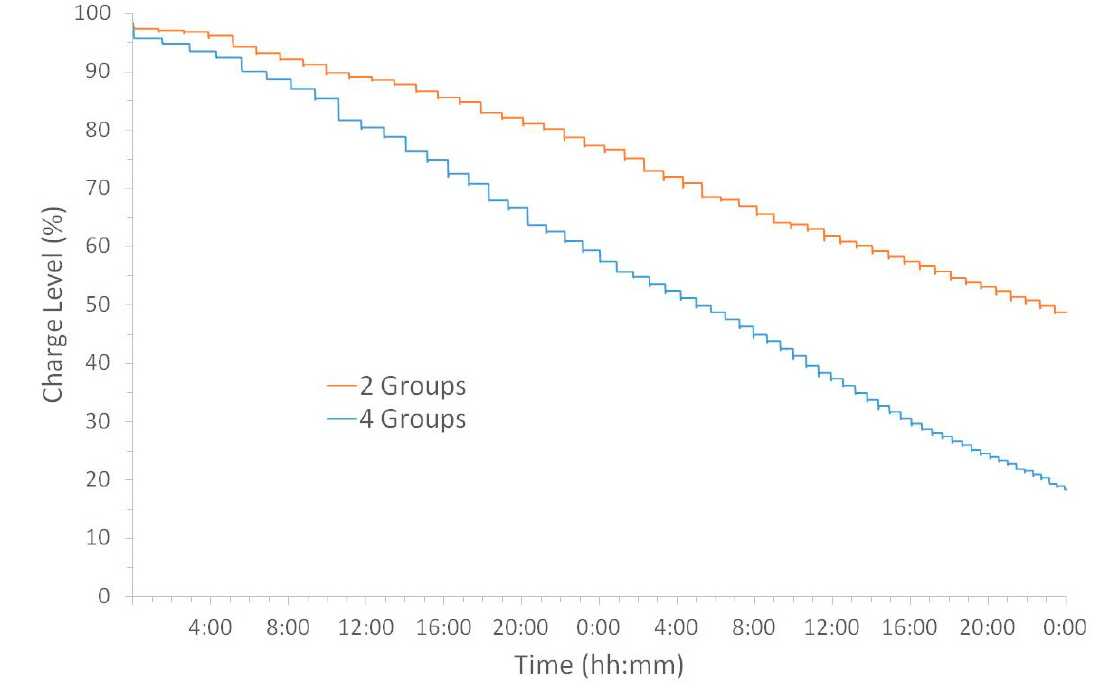
Figure 11. Rates of self-discharge in standby mode when two or four groups of stacks were active (i.e., ready to provide energy to the battery for a fast start-up of a charging or discharging